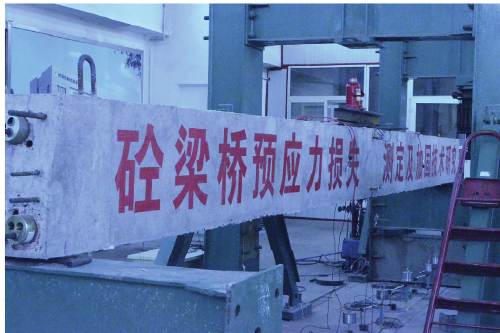
Figure 2: Data acquisition and loading test.